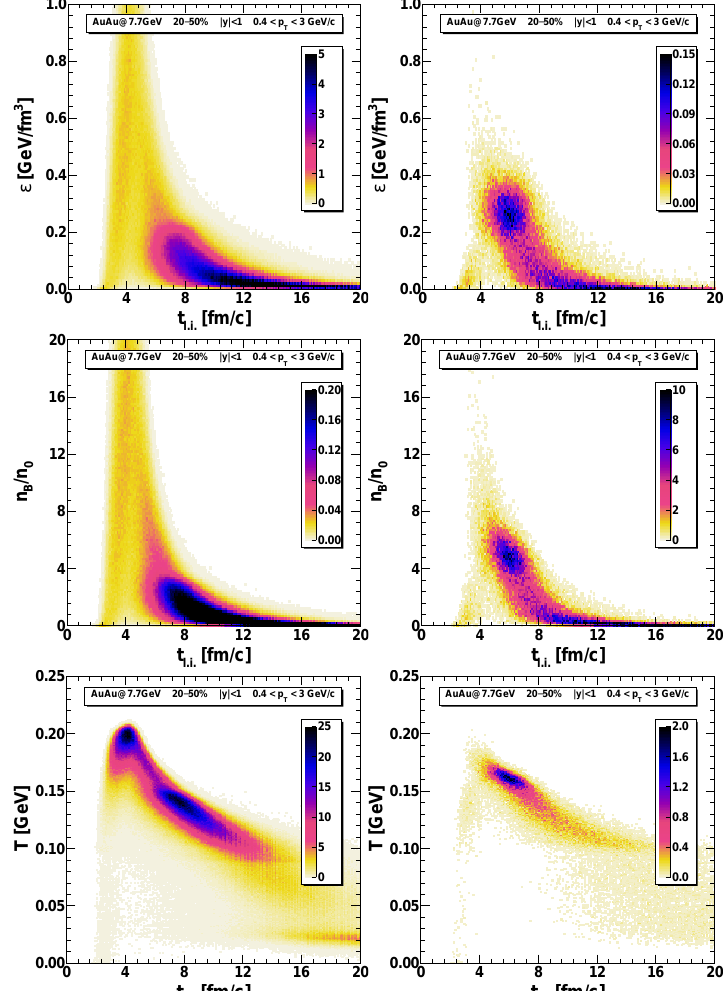
Figure 4. The distributions at the TLI of the energy density ε ( first row ), baryon density n B in units of the normal nuclear matter density n 0 = 0.16fm − 3 ( second row ), and temperature T ( third row ) for final hyperons ( left column ) and anti-hyperons ( right column ) produced in the central 20–50% √ s NN = 7.7GeV in the mid-rapidity range | y | < 1 for transverse momenta Au+Au collisions at 0.4 < p T < 3GeV/ c . All histograms are normalized on the number of collision events. The following bin width are used: 0.01GeV/fm 3 for the energy denstiy, 0.17 n 0 for the baryon density, 1MeV for the temperature, and 0.1fm/ c for t l.i.